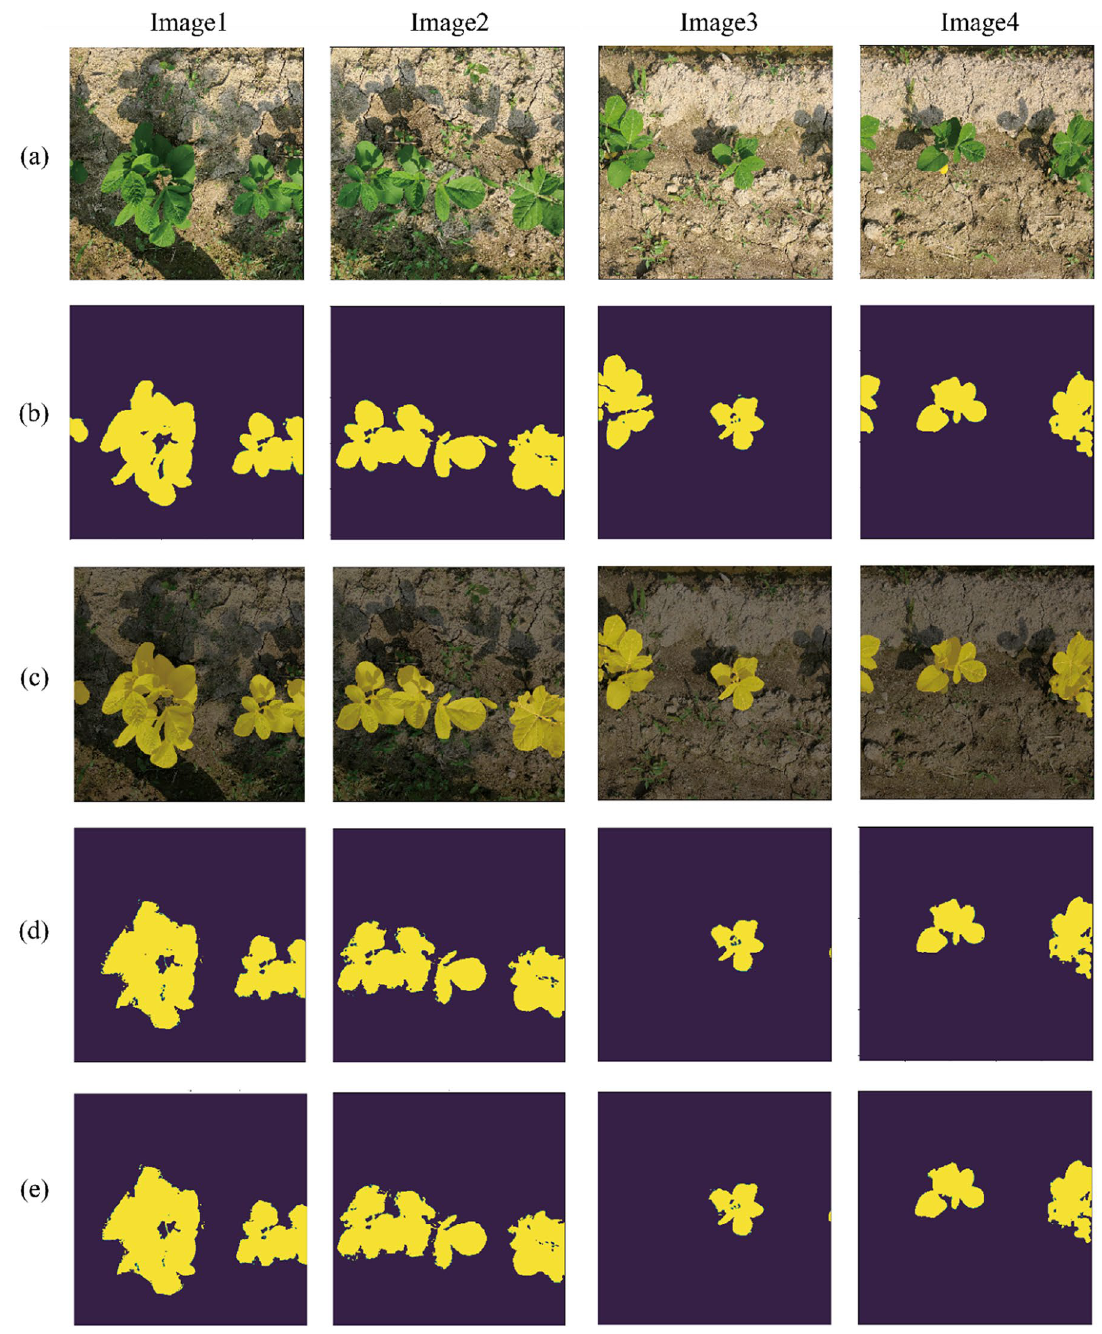
Figure 11. Qualitative Comparison of output by the proposed method and filter on the Bean-Field dataset. ( a ) the input image, ( b ) the output of the proposed method, ( c ) overlay of the output on the input image ( d ) output when average filter is applied and ( e ) output when a median filter is placed on a